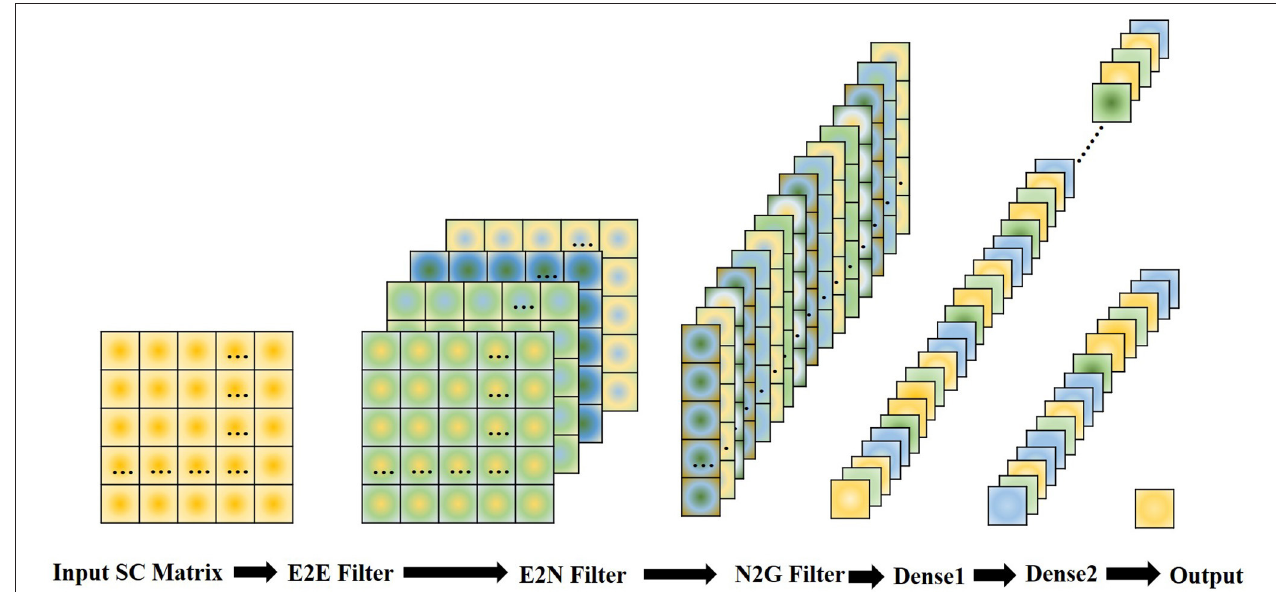
FIGURE 5 | Structure of the BrainNetCNN network.